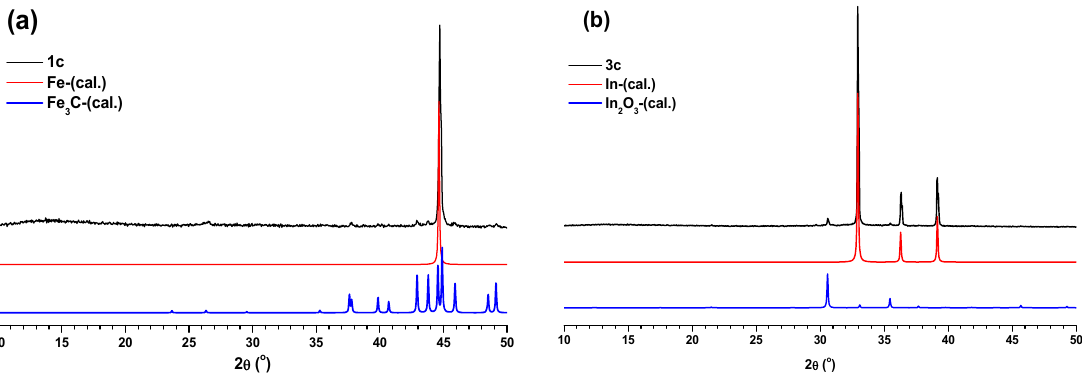
Figure 5. ( a ) Comparison of PXRD pattern of 1c with calculated PXRD patterns of Fe and Fe 3 C. ( b ) Comparison of PXRD pattern of 3c with calculated PXRD patterns of In and In 2 O 3 .